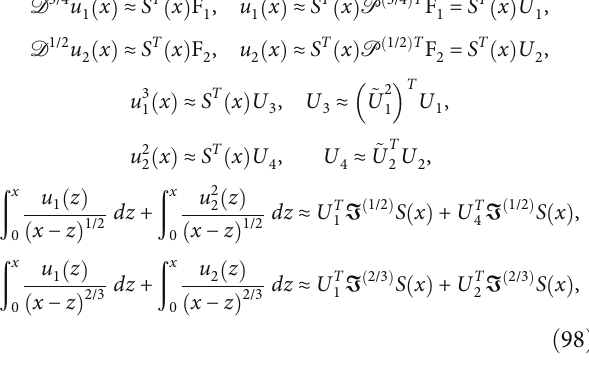
ð x Þ for N = 25 of Example 2